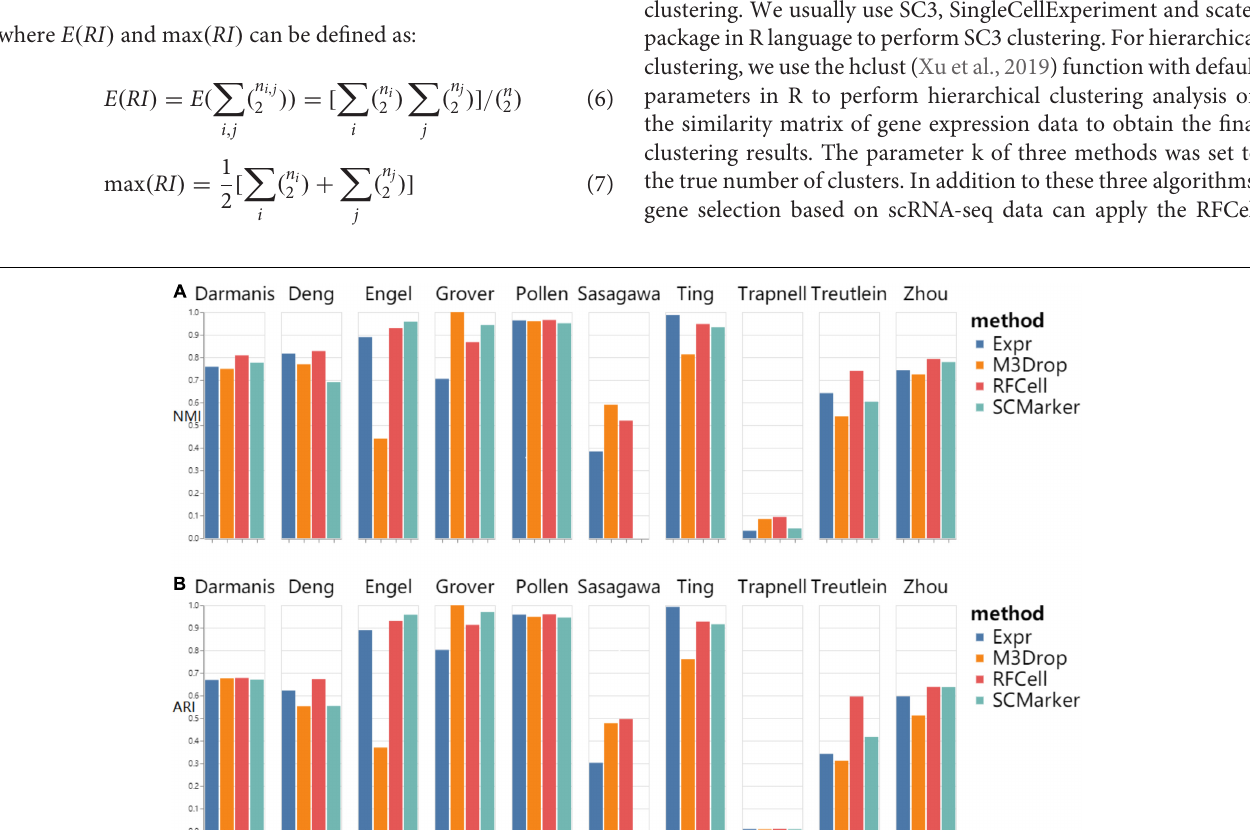
FIGURE 2 | SC3 clustering results based on RFCell and three gene selection methods including Expr, M3Drop, and SCMarker in terms of NMI (A) and ARI (B) .